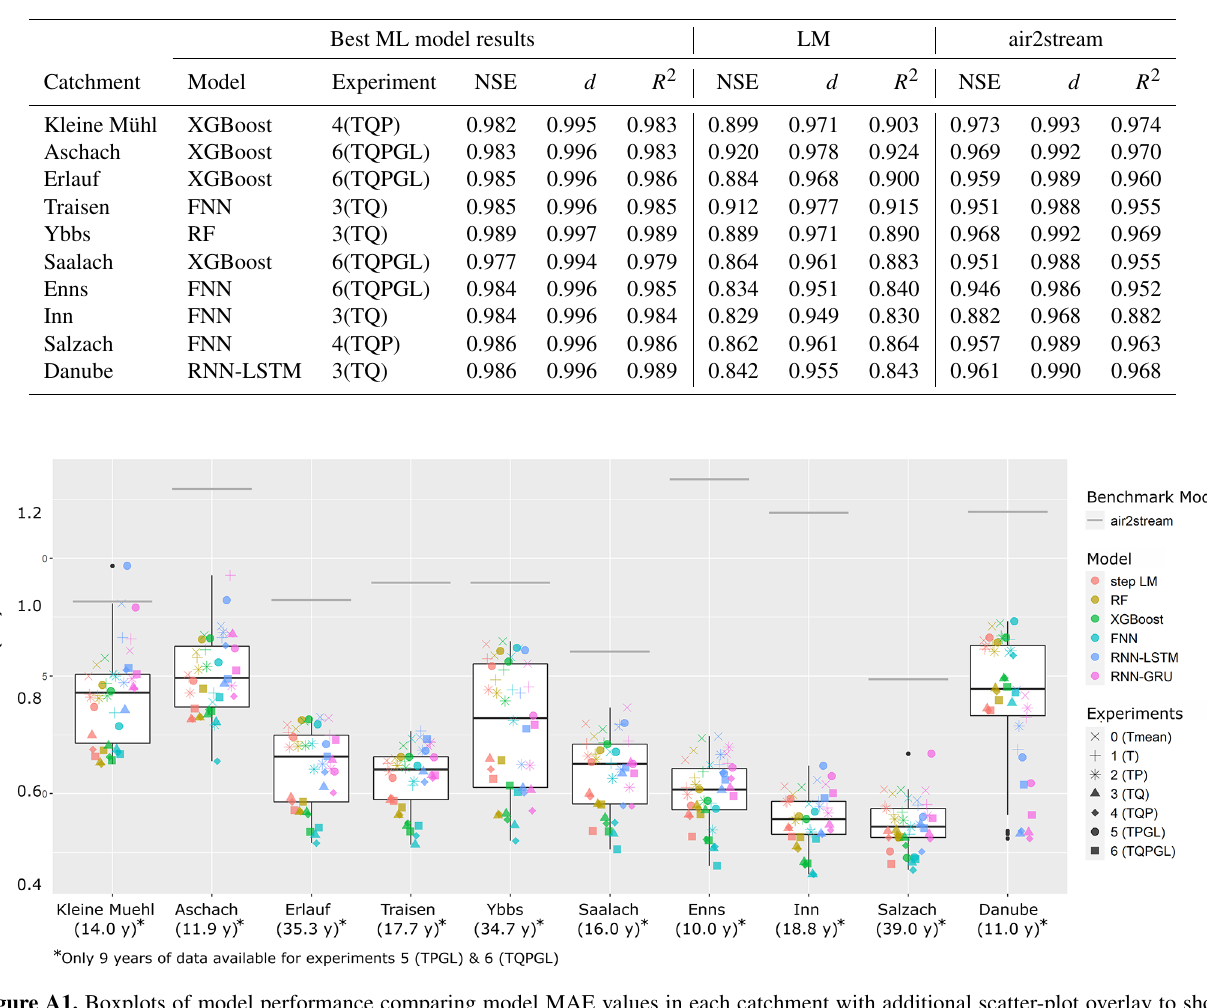
Figure A1. Boxplots of model performance comparing model MAE values in each catchment with additional scatter-plot overlay to show performance of individual combinations of catchments, models and experiments. The catchments are ordered by catchment size from smallest (left) to largest (right) with additional information of the available time-series length in parentheses below. The air2stream benchmark performance is illustrated as grey line for each